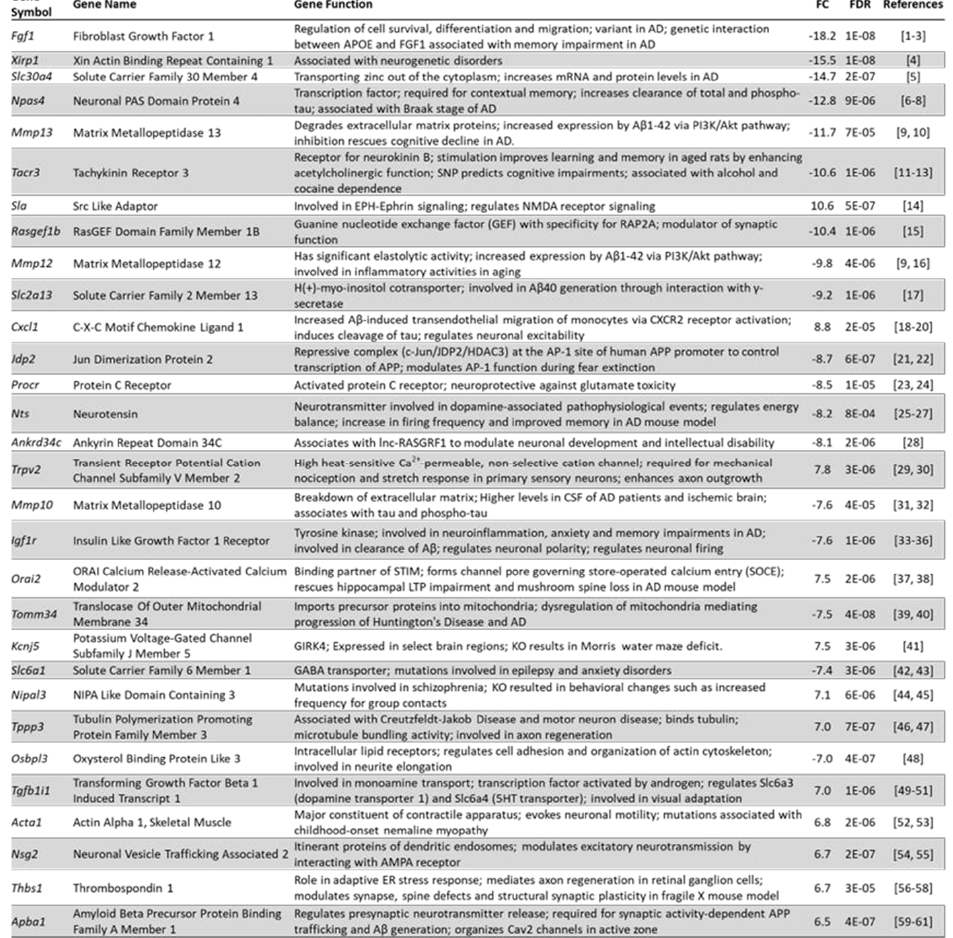
Figure 7. Top ranking genes with neuronal functions . APOE: apolipoprotein E; p-tau: phosphorylated tau; A β : Amyloid beta; PI3K/Akt: phosphatidylinositol 3-kinase/protein kinase B; CSCR2: C-X-C motif chemokine receptor 2; HDAC3: histone deacetylase 3; AP-1: activator protein